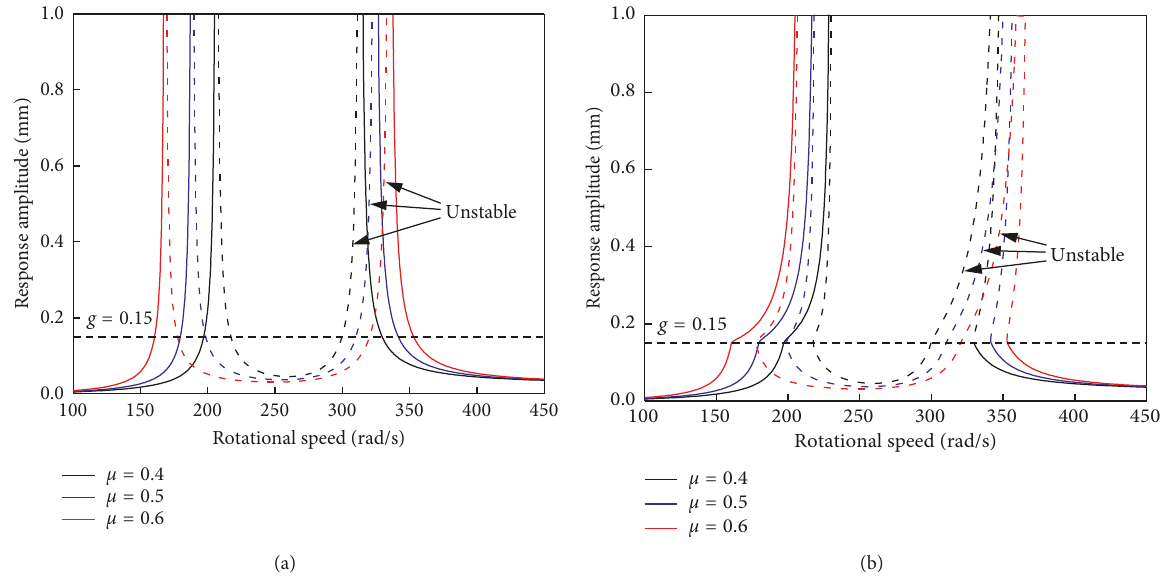
Figure 9: Effects of asymmetry in shaft on the horizontal amplitudes of disk node: (a) rotor without rub-impact and (b) rotor with rub-